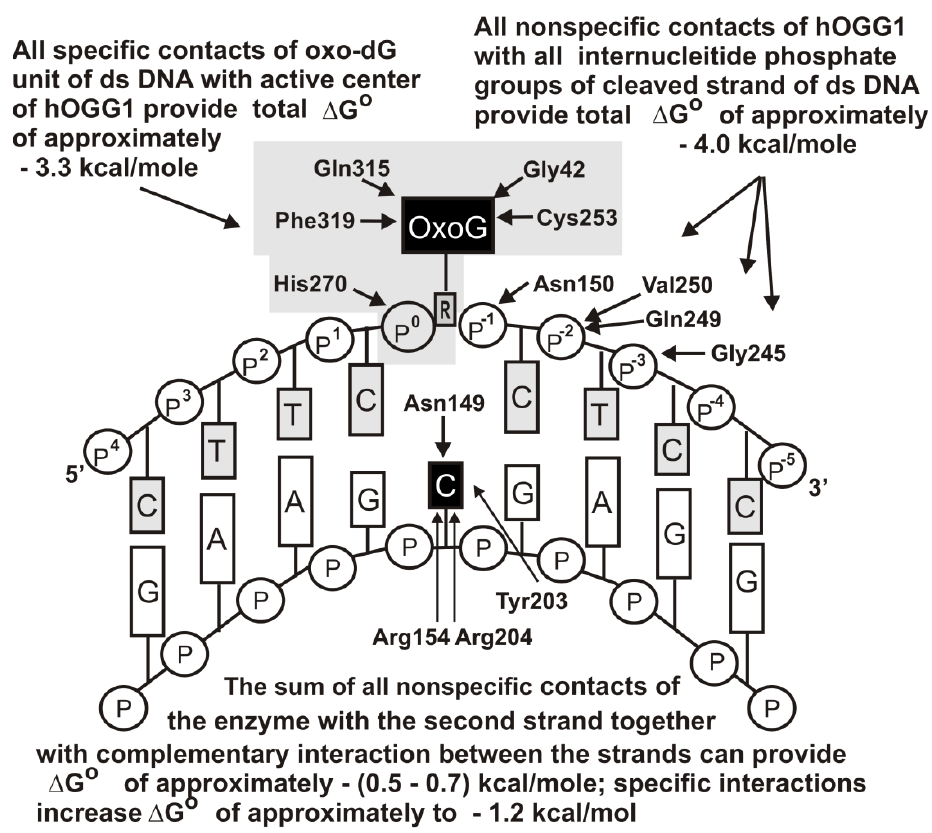
Figure 7. The thermodynamic model of hOGG1interaction of with specific DNA containing 8-oxoG. All types of unspecific contacts are shown on the Panel [59].